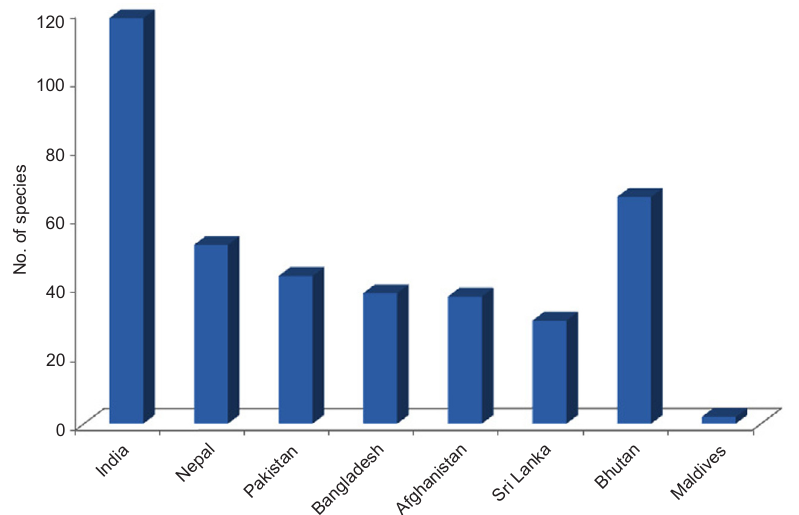
Figure 2. number of bat species occurring in each country of South